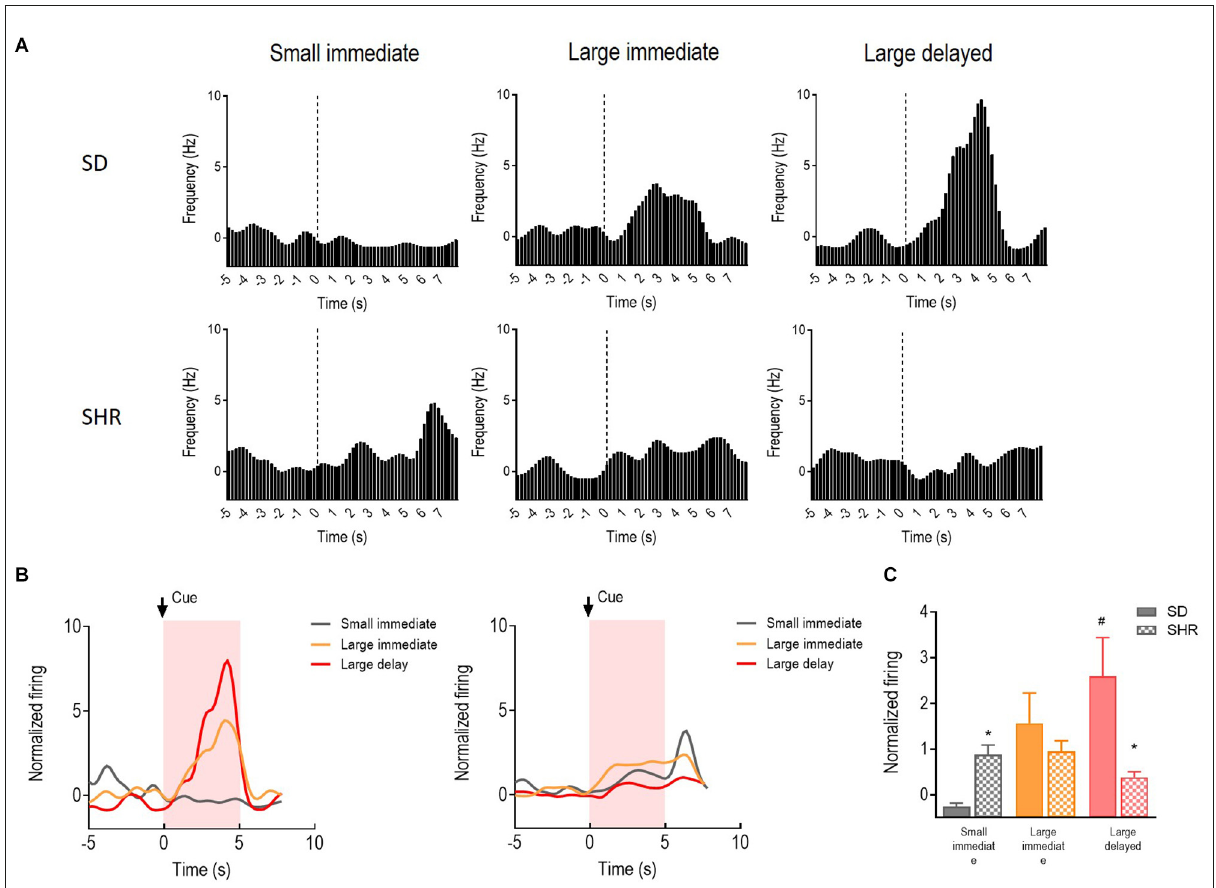
FIGURE4 The OFC neurons respond to reward-predicting cues in SD and SHR rats. (A) Peri-event histograms of representative OFC neurons in SD rats (upper panel) and SHR rats (lower panel) in response to the reward-predicting cue. Data are aligned to cue onset (cue sound starts at time 0, dashed line, last for 3 s). (B) Normalized firing response of all OFC neurons’ response to sized reinforcer in SD rats (left panel) and SHR (right panel) rats. (C) Quantification of the normalized firing rate of OFC neurons in both SD and SHR rats during the 3 s period of cue presentation (highlighted box). * p < 0.05 compared with SD rats; # p < 0.05 compared with small immediate reinforcer within SD